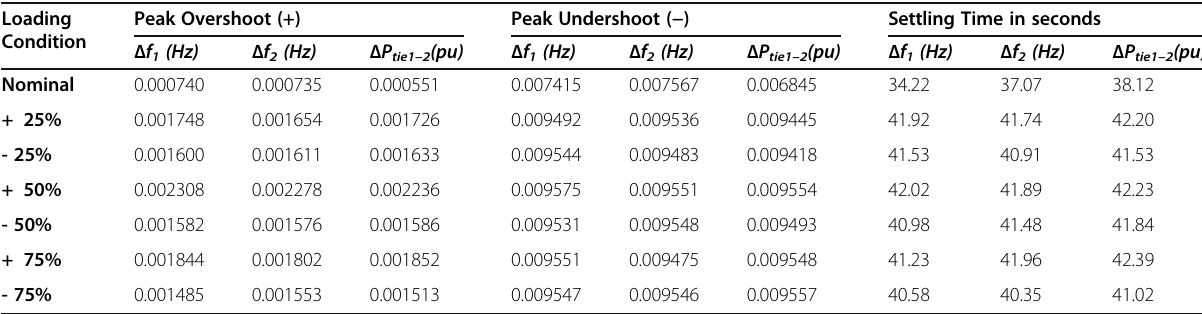
Table 6 Peak deviation & Settling time for GOA optimized PDF plus (1 + PI) controller with different loading conditions Loading